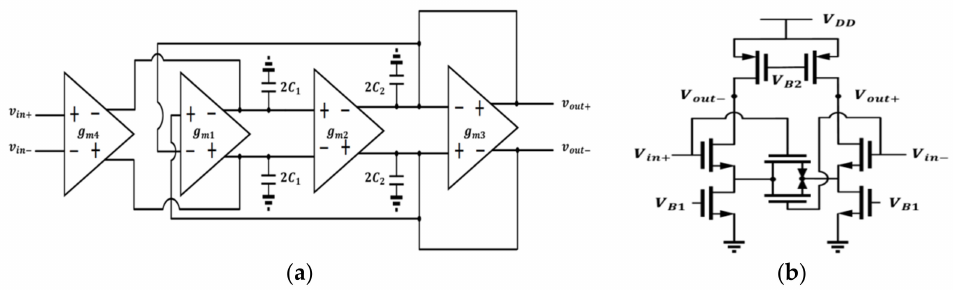
Figure 10. ( a ) The second order bi-quad GM-C filter; ( b ) schematic of the Gm cell